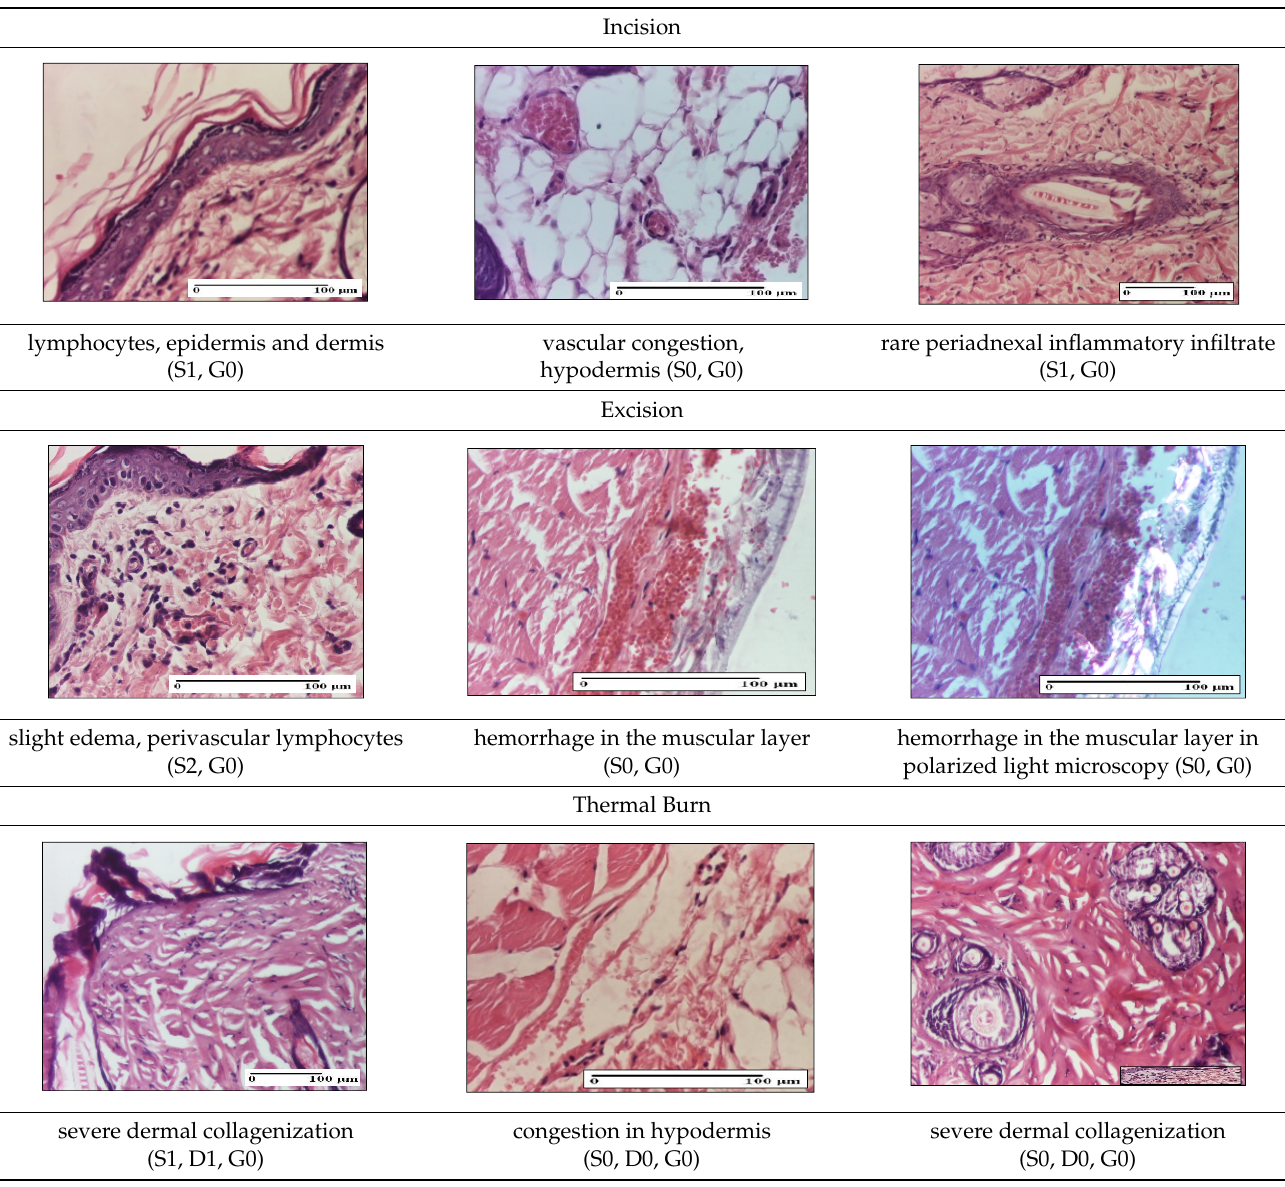
basement membrane, skin appendages remain intact; D3—necrosis of skin appendages and dermal connective tissue; D4—extensive necrosis within the hypodermic tissue. Gradation of infection (G): G0—no microorganisms are identified in the sections, GI—microorganisms are identified on the surface of the lesion, GI a —several microbial elements are highlighted, GI b —many microbial elements are highlighted, GII—microorganisms affect the superficial dermis, GIII— microorganisms affect the entire thickness of the dermis, GIV—microorganisms extensively affect the adjacent viable tissues and the